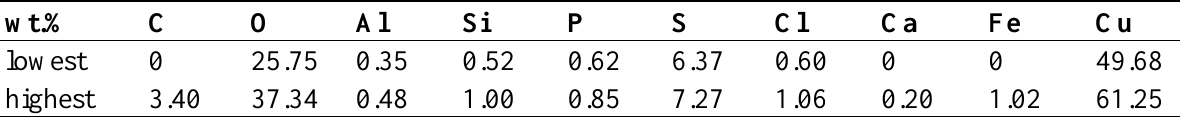
Table 1. Results of EDS point analyses of the surface deposit from the green part of the copper sheet from Wilanów Palace (range of percentage composition determined by measurements from three different